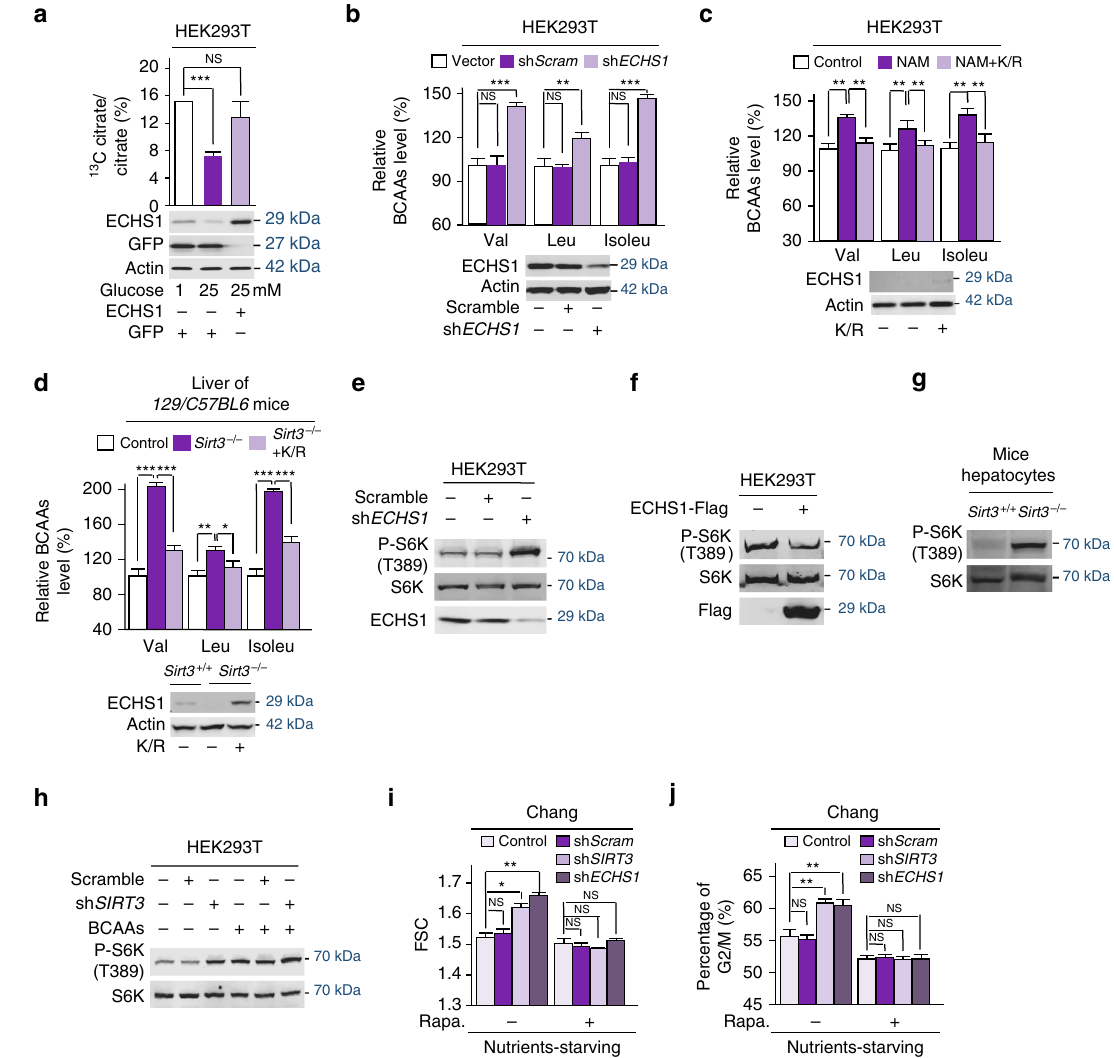
Fig. 7 Nutrient activates mTOR signaling by accumulating BCAAs. a The conversion of Leucine-1,2- 13 C 2 to 13 C-labeled citrate was traced by targeted liquid-chromatography tandem mass spectrometry (LC – MS/MS) in HEK293T cells cultured in low (1 mM) and high (25 mM) glucose media, and in ECHS1 overexpressing HEK293T cells cultured in high glucose media. b The BCAA levels in HEK293T cells and ECHS1 knocked down HEK293T cells were determined ( n = 4). BCAA levels were normalized to those of HEK293T cells. c BCAA levels of HEK293T cells, NAM treated HEK293T cells, and NAM treated HEK293T cells with overexpression of ECHS1 K101R were determined by GC – MS ( n = 4). All levels were normalized to those of HEK293T cells. The expression of ECHS1 K/R was con fi rmed by western blot. d BCAAs levels in the liver of 129/C57BL6 mice, Sirt3 knockout 129/C57BL6 mice, and ECHS1 K101R overexpressing Sirt3 knockout 129/C57BL6 mice were determined ( n = 6). ECHS1 K/R expression was achieved by tail vein injection of the ECHS1 K/R plasmid, and the expression was con fi rmed by western blot. BCAA levels were normalized to those in the liver of isogenic control mice. e The levels of P- T389 on S6K were determined in HEK293T cells with and without ECHS1 knockdown. f The levels of P-T389 on S6K were determined in HEK293T cells with and without ECHS1 overexpression. g The levels of P-T389 on S6K were determined in the hepatocytes of Sirt3 KO and its isogenic control mice. h The effects of sh SIRT3 knockdown (for knockdown effects see Figure 4) on P-T389 of S6K were detected in HEK293T cells cultured with or without BCAA supplementation in the medium. i The cell size of Chang cells and ECHS1 or SIRT3 knocked down Chang cells were determined by measuring forward side scatter (FSC) in the presence or absence of rapamycin. j The percentage of Chang cells and ECHS1 or SIRT3 knocked down Chang cells in the G2/M phase was determined by fl uorescence-activated cell sorter (FACS) in the presence or absence of rapamycin. For all fi gures, mean values with SD are reported. NS not signi fi cant; * P < 0.05; ** P < 0.01; *** P < Fig. 6b), and the proteasomal inhibitor MG132 blocked the NAM- (Fig. 5a) and high glucose-induced (Fig. 5b) decrease of endogenous ECHS1 protein levels. Furthermore, nutrients pro- moted ubiquitination of ECHS1 in HEK293T cells (Fig. 5c). These results suggest that nutrient-enhanced acetylation pro- motes proteasomal degradation of ECHS1, which was further con fi rmed by the fact that MG132 and NAM treatments syner- gistically enhanced ECHS1 ubiquitination (Fig. 5d). Moreover, the ubiquitination level of the acetylation mimetic K/Q mutant,